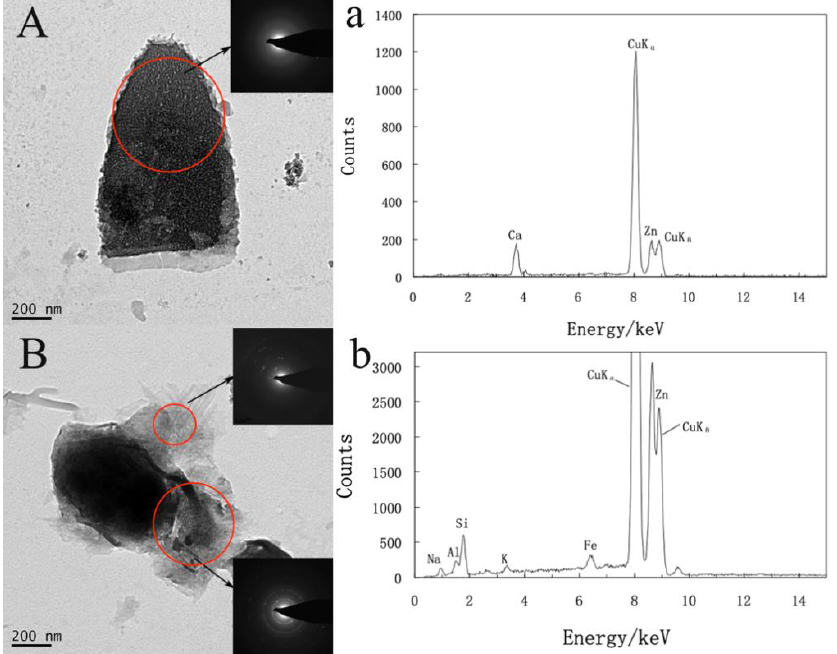
Figure 5. TEM images with SAED patterns of minerals formed on bacteria cells’ surface ( A , B ); the EDS spectrum of minerals ( a , b ). Cu and Zn are background signals in the EDS spectrum.